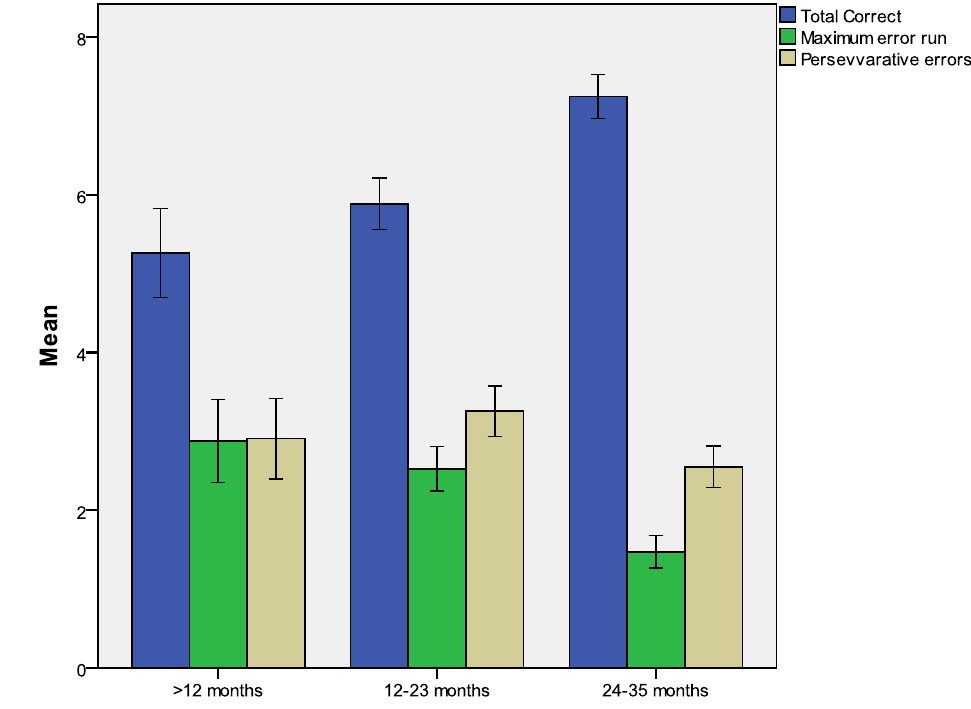
Figure 1. Performance of children in the A-not-B task across different age